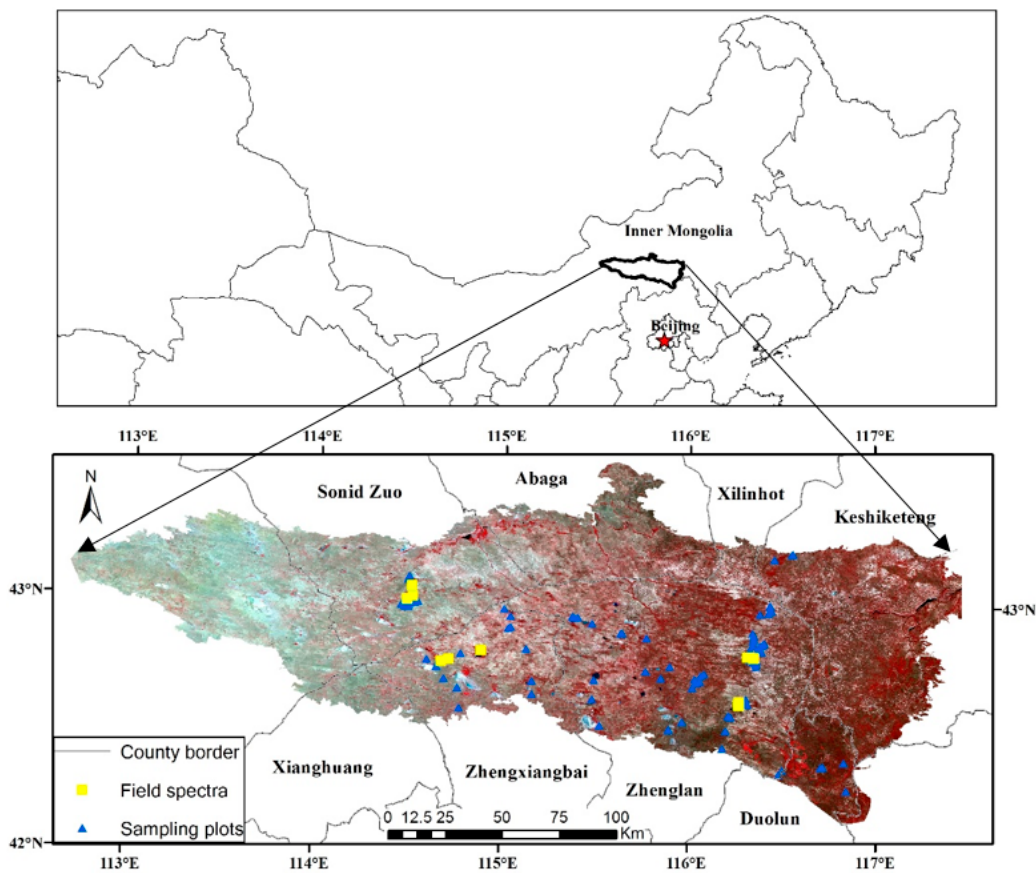
Figure 1. Location of the study area in North China.